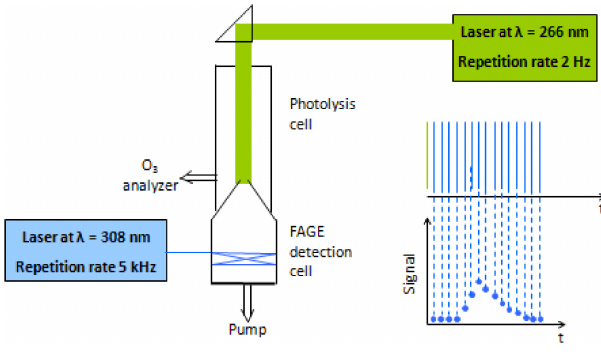
Figure 1. Schematic view of the experimental